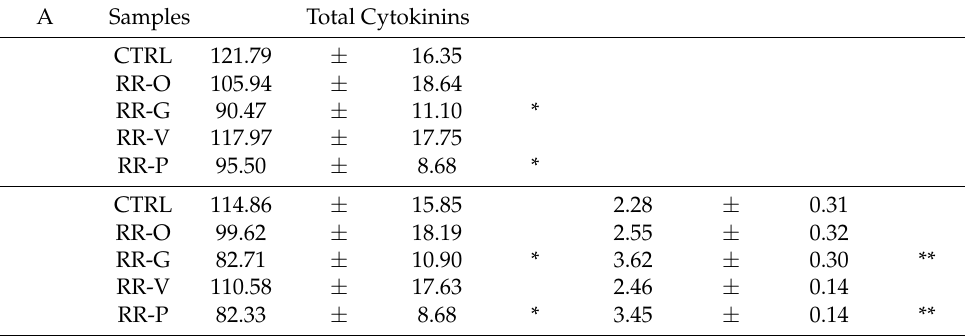
Table 1. Cytokinin levels in pmol · g − 1 FW (mean ± SD; RSD = relative standard deviation; statistically significant difference in treated plants versus control (untreated plants) in a paired Student’s t -test (*, **, and *** correspond to p -values of 0.05 > p > 0.01, 0.01 > p > 0.001, and p < 0.001). ( A ) Total CK content, ( B ) total CK O - and N -glucosides, ( C ) total CK bases and CK ribosides, ( D ) N 6